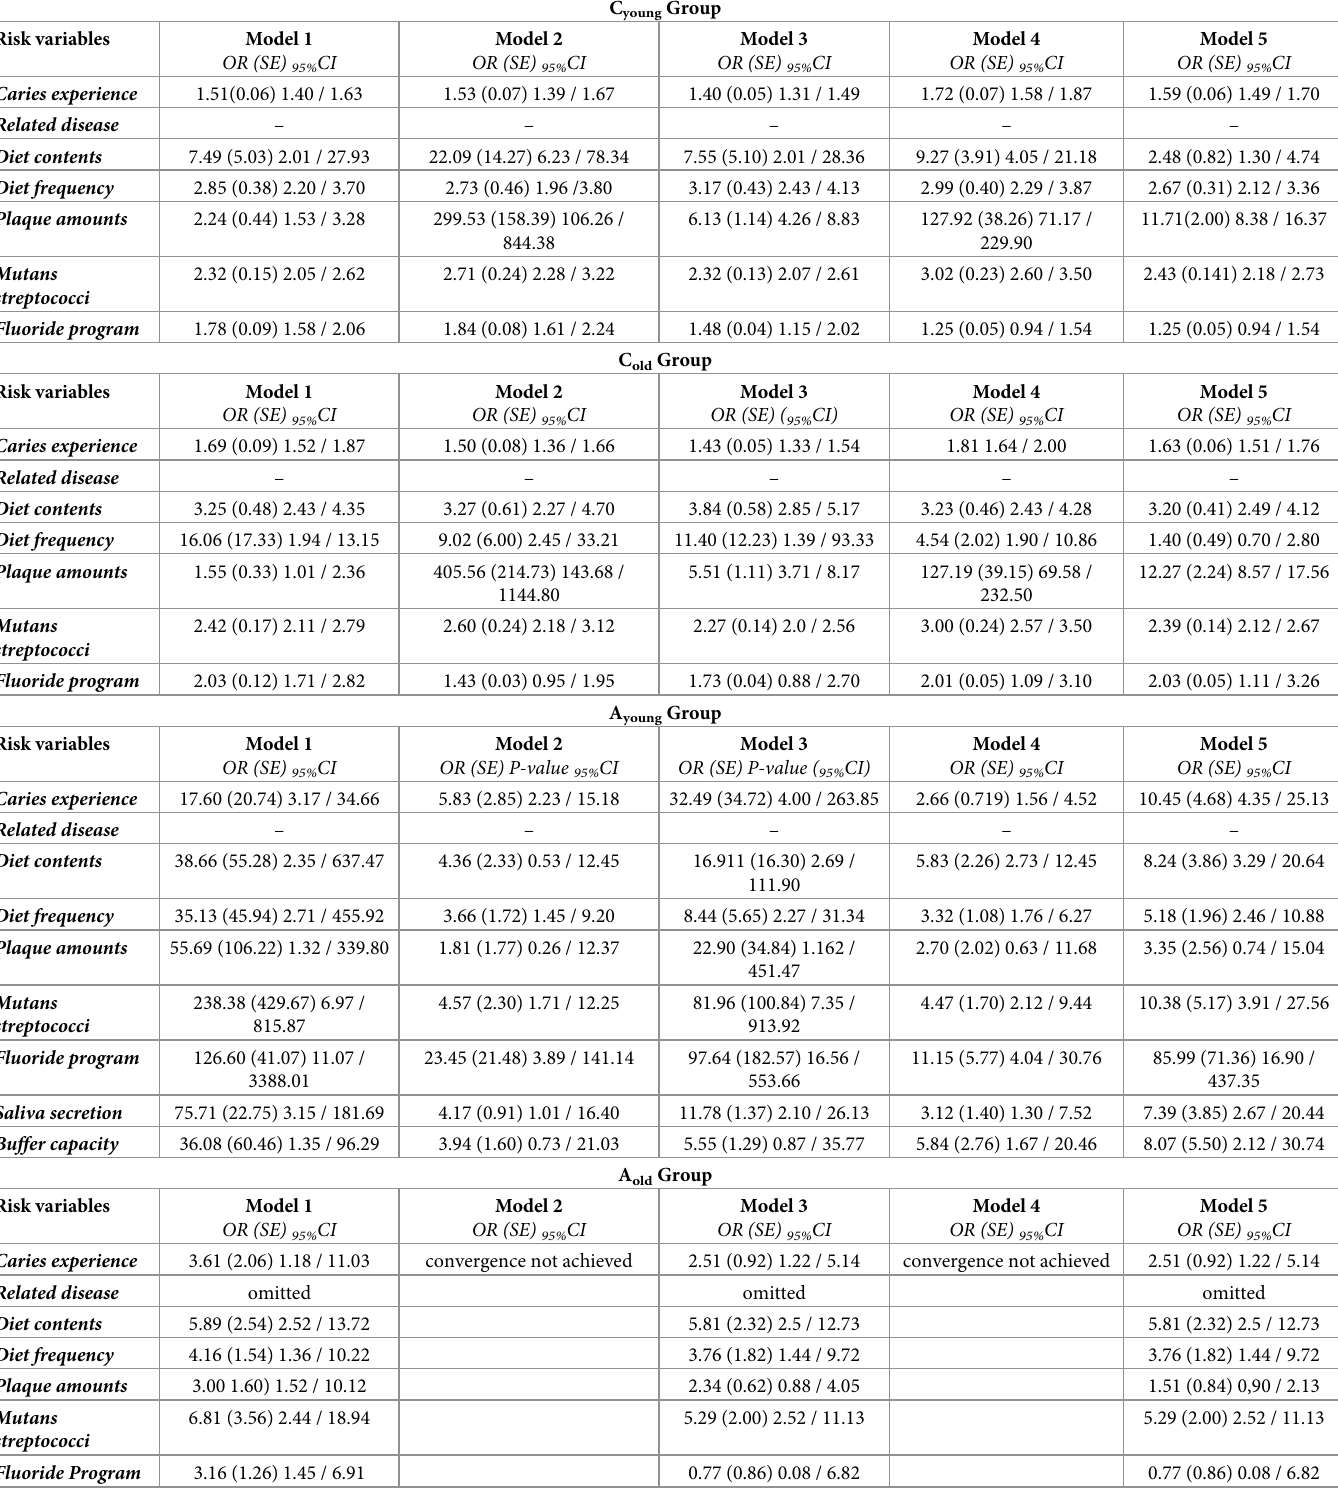
Table 4. Multinomial regression analysis. Cariogram risk categories as dependent